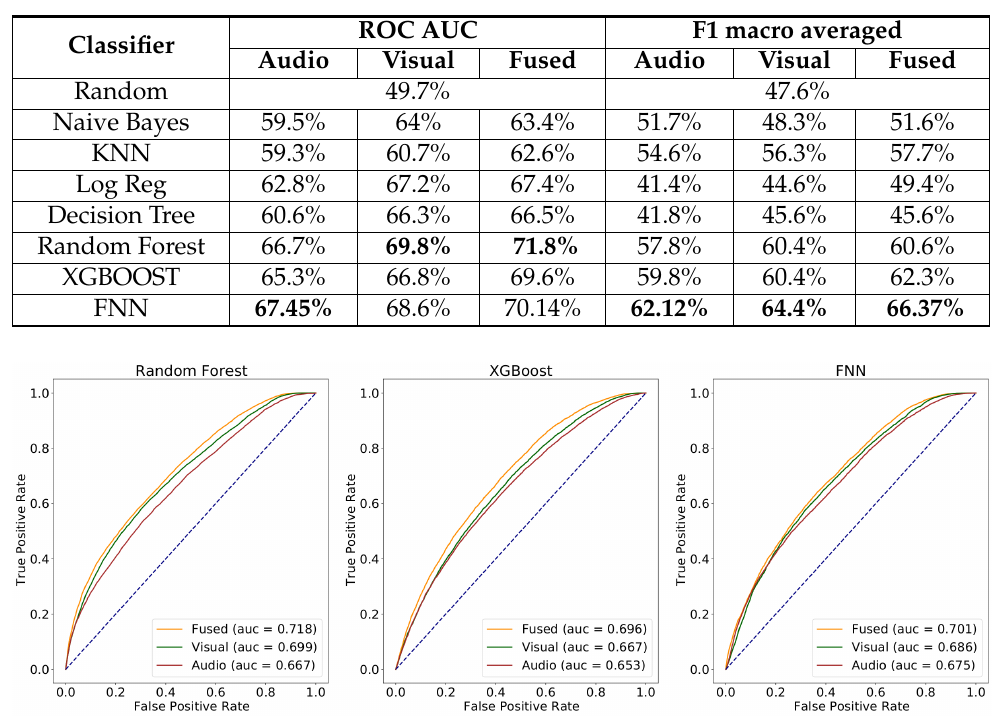
Table 4. Segment Level Metrics. Best performance per modality/metric is indicated in bold.